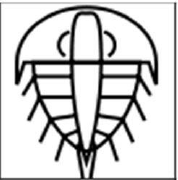
Figure 8 . Visualization of the symbol after editing in Inkscape.